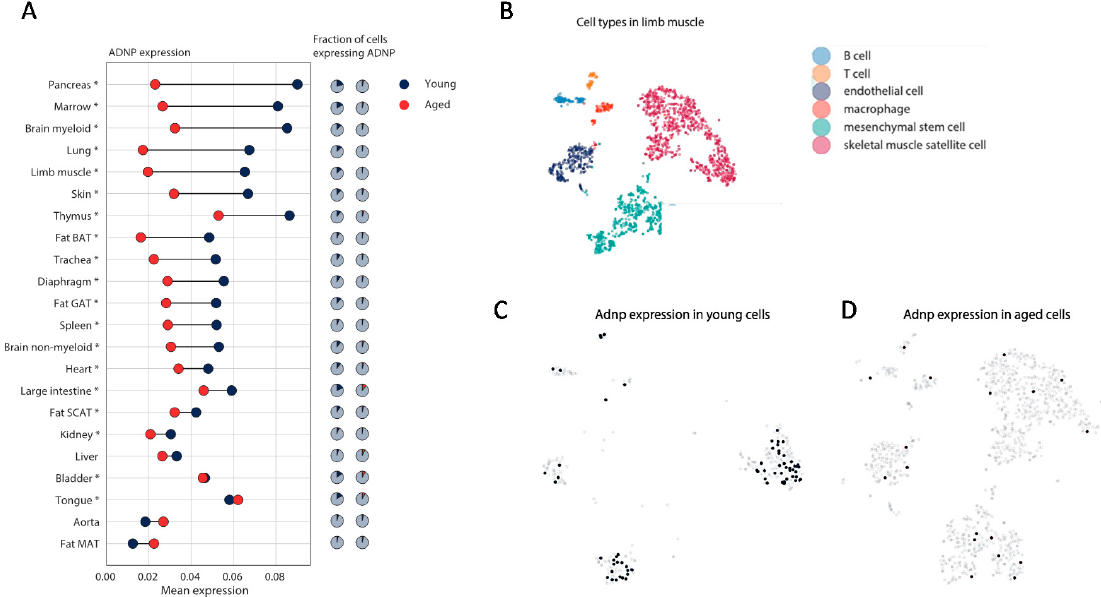
Figure 4. Adnp expression is downregulated with age, specifically in limb muscle cells. ( A ) Mean Adnp expression in young (3 months) and aged mice (18 and 24 months) in 22 tissues (indicated in rows). GAT, SCAT, MAT and BAT stand for gonadal-, subcutaneous-, mesenteric- and brown-adipose tissue. Asterisk indicates * p < 0.05 using the Wilcoxon rank-sum test. ( B ) Annotated cell type clusters in the limb muscle tissue. ( C ) Out of 542 limb muscle cells in the young mouse 70 express Adnp (overlaid as dark blue dots). ( D ) Out of 1315 limb muscle cells in the aged mouse 18 express Adnp (overlaid as light blue dots).